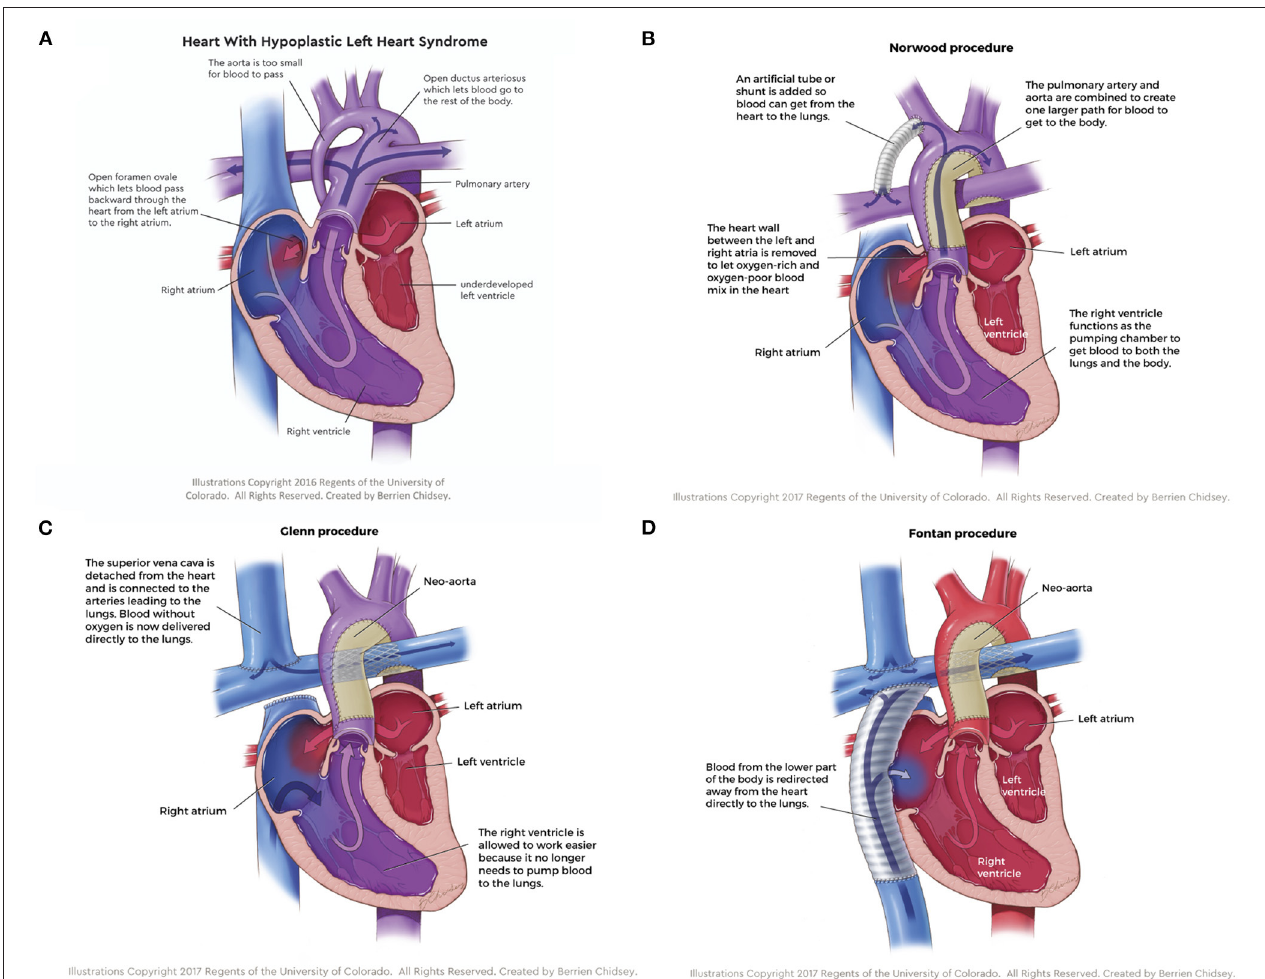
FIGURE 1 | (A) Hypoplastic left heart syndrome, the most common type of single ventricle disease, is characterized by an underdeveloped left side of the heart. (B) The stage I Norwood procedure establishes an unobstructed pathway from the ventricle to the body and diverts a pressure-limited supply of blood to the lungs. (C) The stage II Glenn procedure directs all superior systemic venous flow directly to the pulmonary artery, which reduces the volume load on the single ventricle, thereby decreasing wall stress and ventricle wall hypertrophy. (D) The stage III Fontan-Kreutzer procedure places the pulmonary and systemic circulation in series, introducing passive flow into the pulmonary circuit while the functional right ventricle pumps oxygenated blood to the systemic